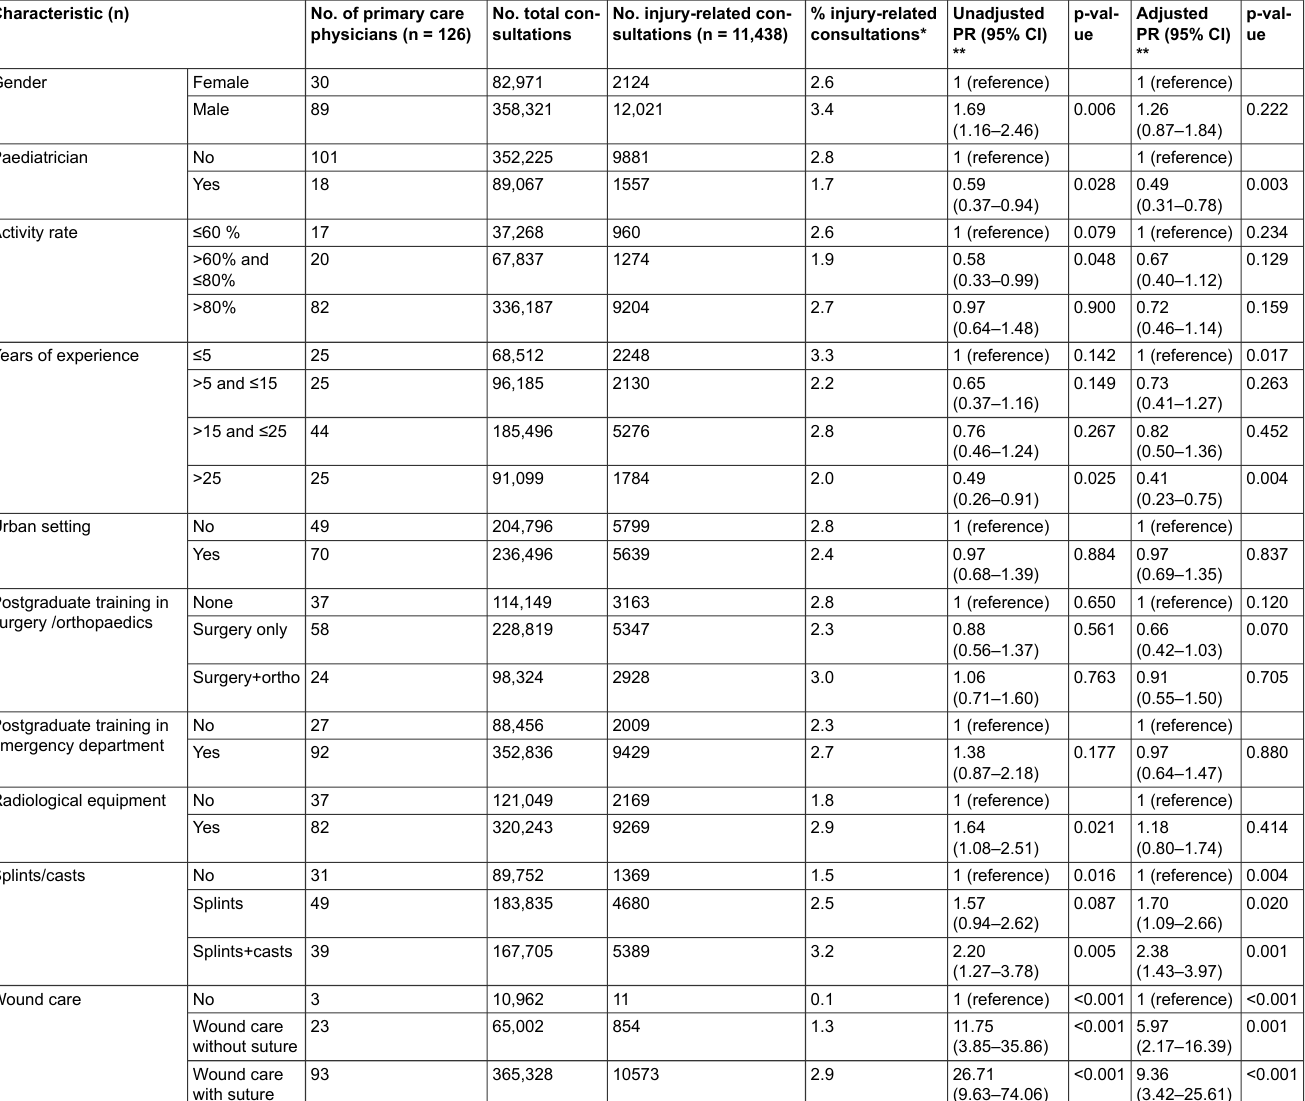
Table 3: Multivariable negative binomial regression analysis of the association between different primary care physician characteristics at the practice and prevalence of injury related consultations. Characteristic (n)